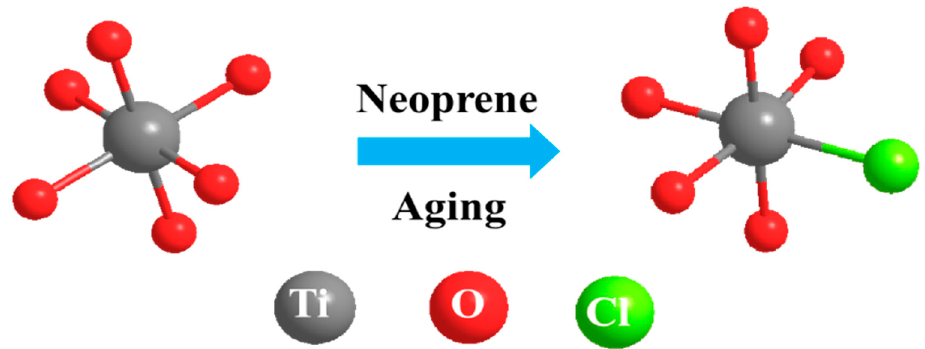
Scheme 5. Chemical structures of the three types of dyes used for photocatalytic